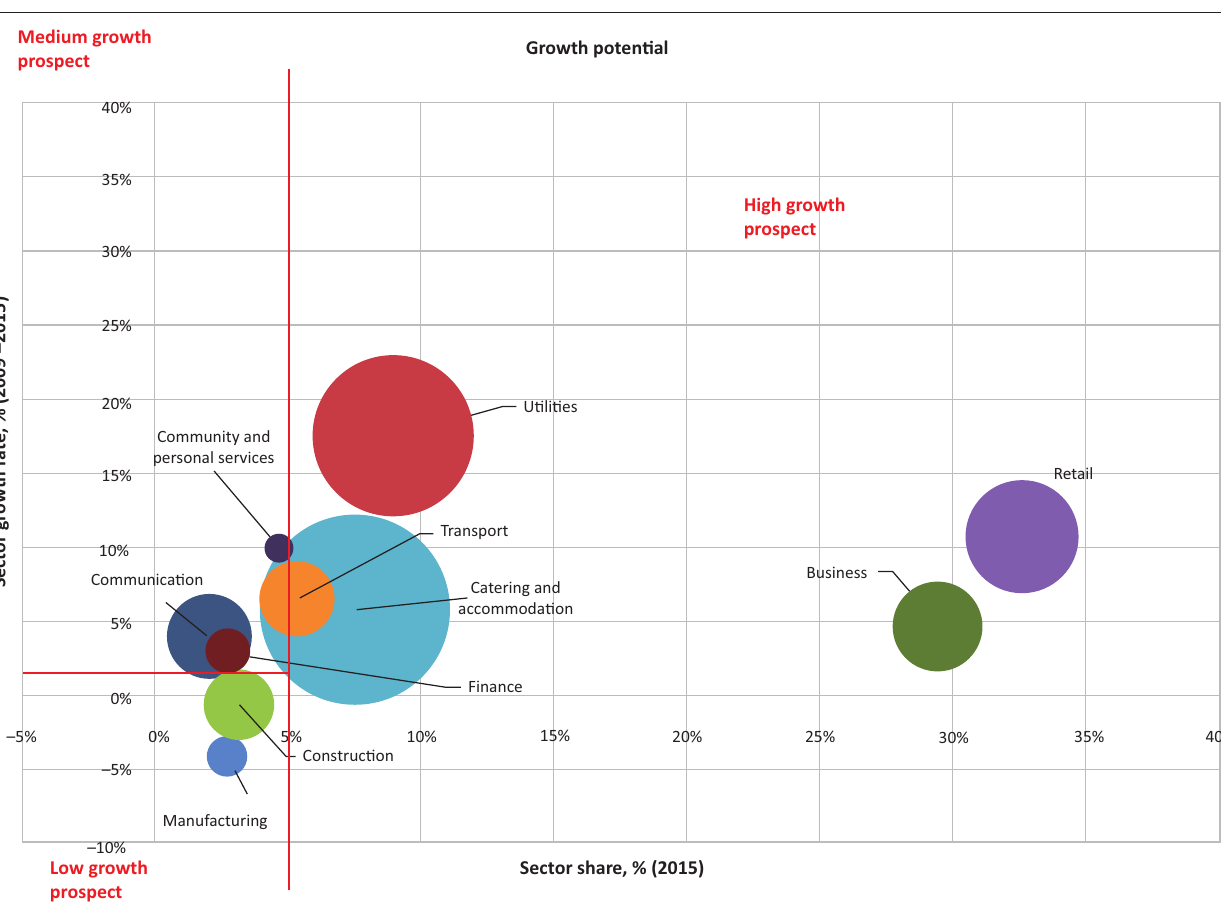
FIGURE 10: Growth prospects per